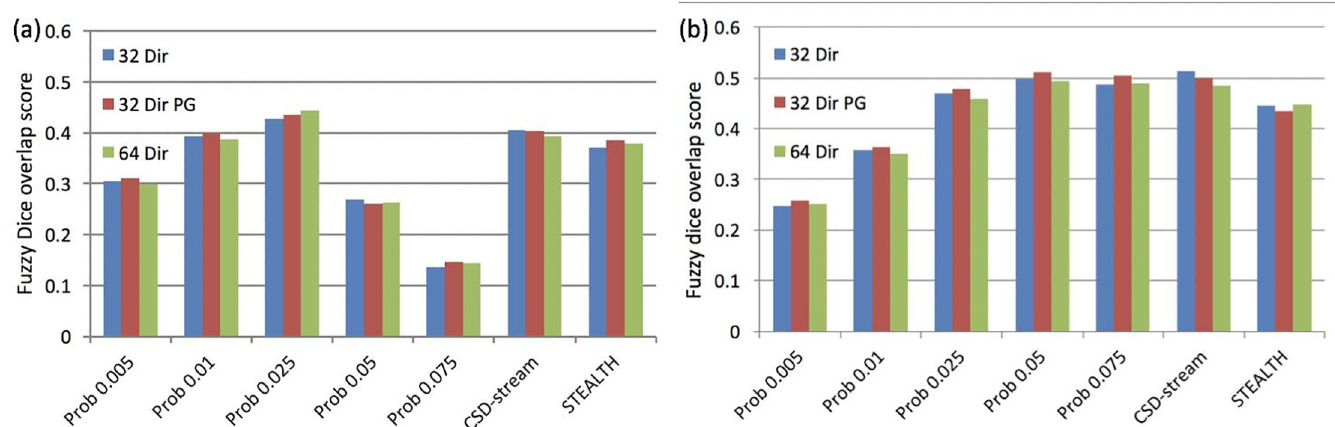
Fig 3. Fuzzy Dice overlap scores between the tractography and the Ju¨lich atlas for (a) the CST and (b) the OR. Labels as per main text.